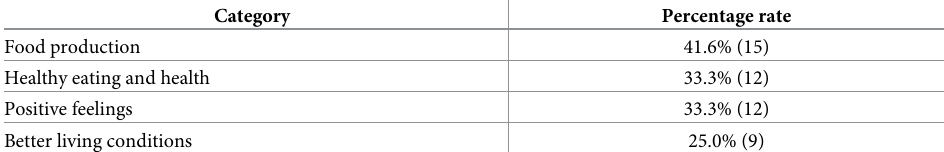
Table 3. Categories of families’ perception of what has changed in their lives in recent years and how the cistern helps them. Semi-arid region of Alagoas, Brazil, 2016.